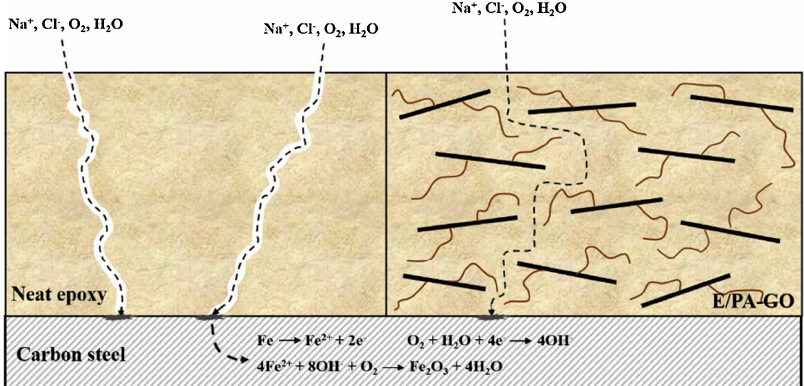
Figure 3. The corrosion mechanism of epoxy resin reinforced with PA-GO (Reprinted with permission from ref. [83] 2020 Elsevier).